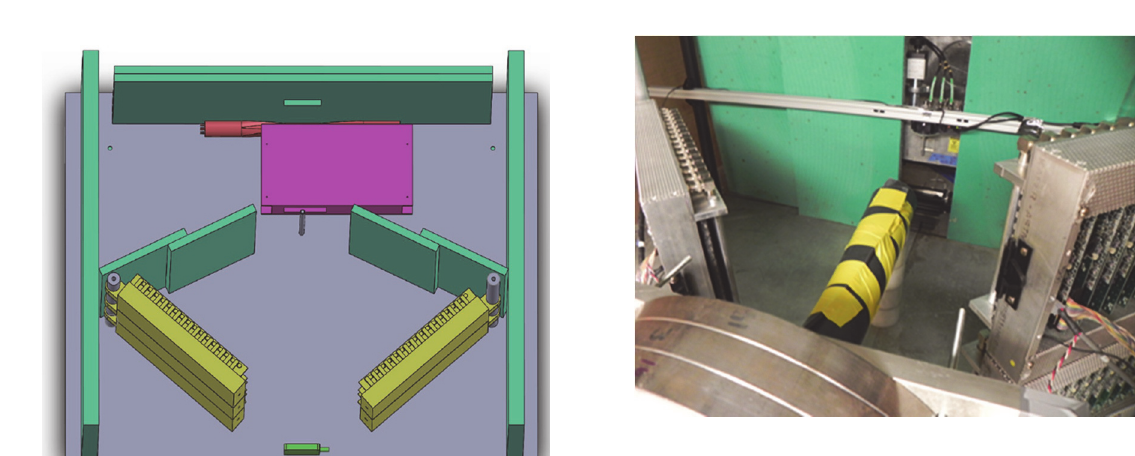
Fig. 4. Photograph of the first tests of the LANSCE-in-a-box multi-modal portable neutron instrument. The 3 He detector panels as well as the multi-channel plate imaging detector (behind green borated polytehtylene walls) are visible. A 6 mm diameter vanadium can with a sample is visible in front of the imaging detector. The black borated plastic, rolled into a pipe, reduced air